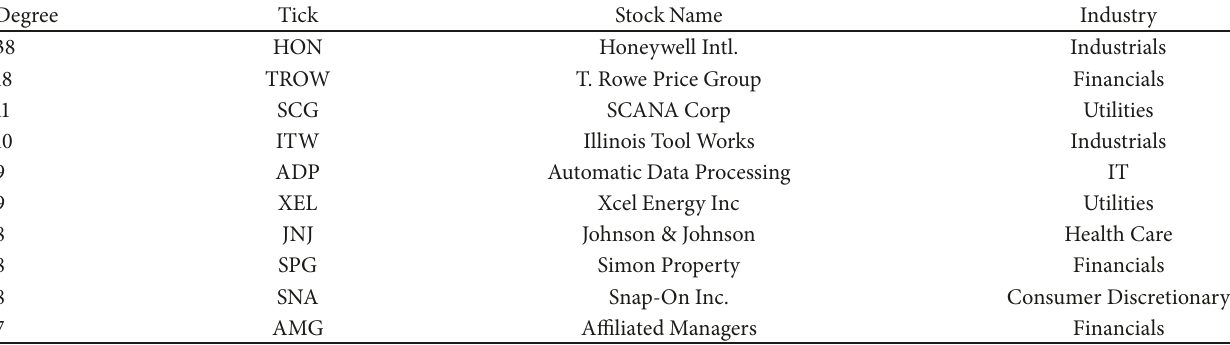
Table 11: In this table, we present the top 10 stocks with the largest degrees in the MST of S&P468. As is shown, Honeywell Intl. is the most connected stock in the MST with a degree of 38. The top 10 stocks are composed of 2 Industrials stocks, 3 Financials stocks, 2 Utilities stocks, 1 Health Care stock, and 1 Consumer Discretionary stock. Degree Tick Stock Name Industry Honeywell